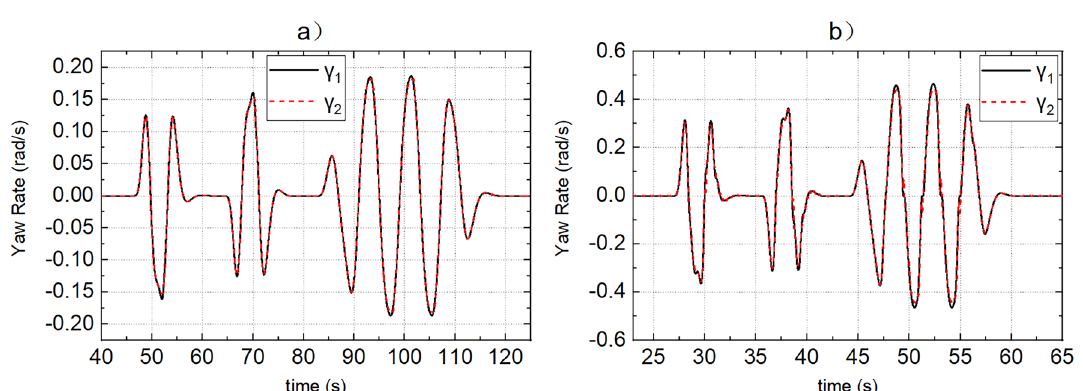
Figure 9. ( a , b ) Show the actual yaw rate when the road adhesion coefficients are 0.15 and 0.8, respectively. Curve 1 represents the SCS effect, and curve 2 represents the MMCCS